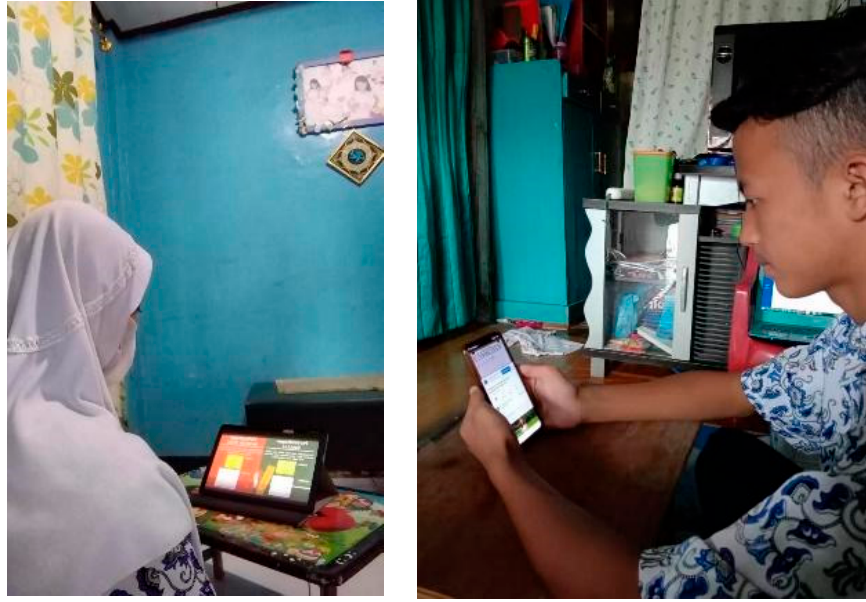
Figure 5. Students use micro-lectures to preview direct and inverse proportion topics at